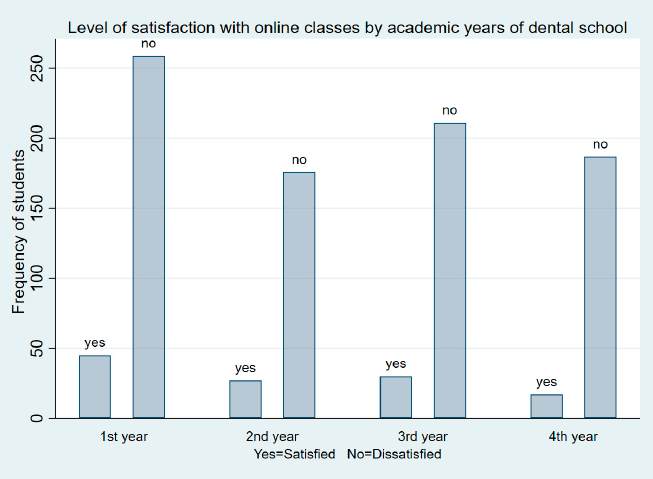
Figure 1. Satisfaction levels of students with online classes by academic years of dental school. Table 2. Bivariate analysis (Pearson’s chi-square) between several factors and level of satisfaction with online